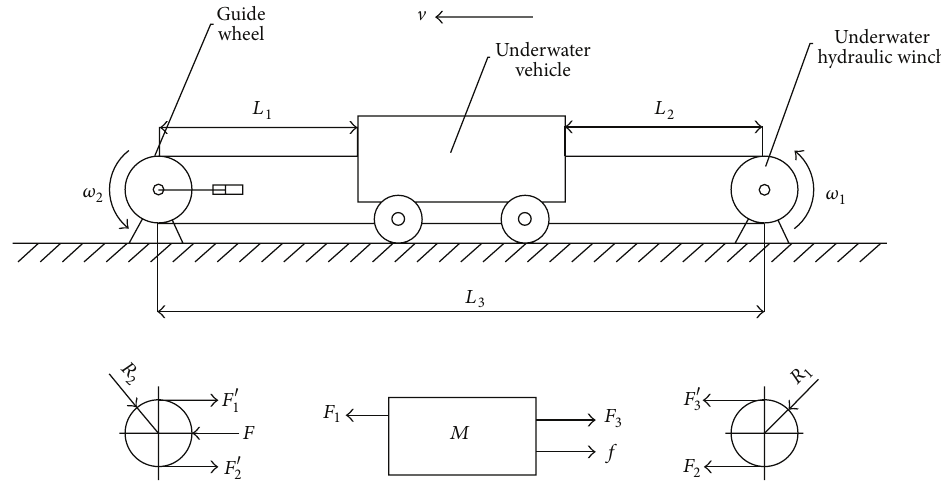
Figure 3: Schematic diagram of the underwater vehicle drafted by hydraulic winch.